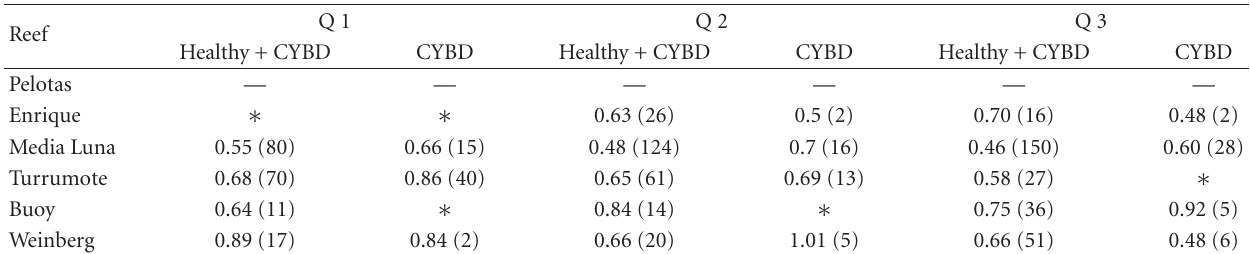
Table 4: Colony distribution departure from randomness; z and P values (in parenthesis) from the test of significance for the three 100 m 2 quadrants in the di ff erent sites. (—): no data was found. ( ∗ ): not significant data. Q 1 Reef Pelotas — — — — — — Enrique ∗ ∗ Media Luna Turrumote ∗